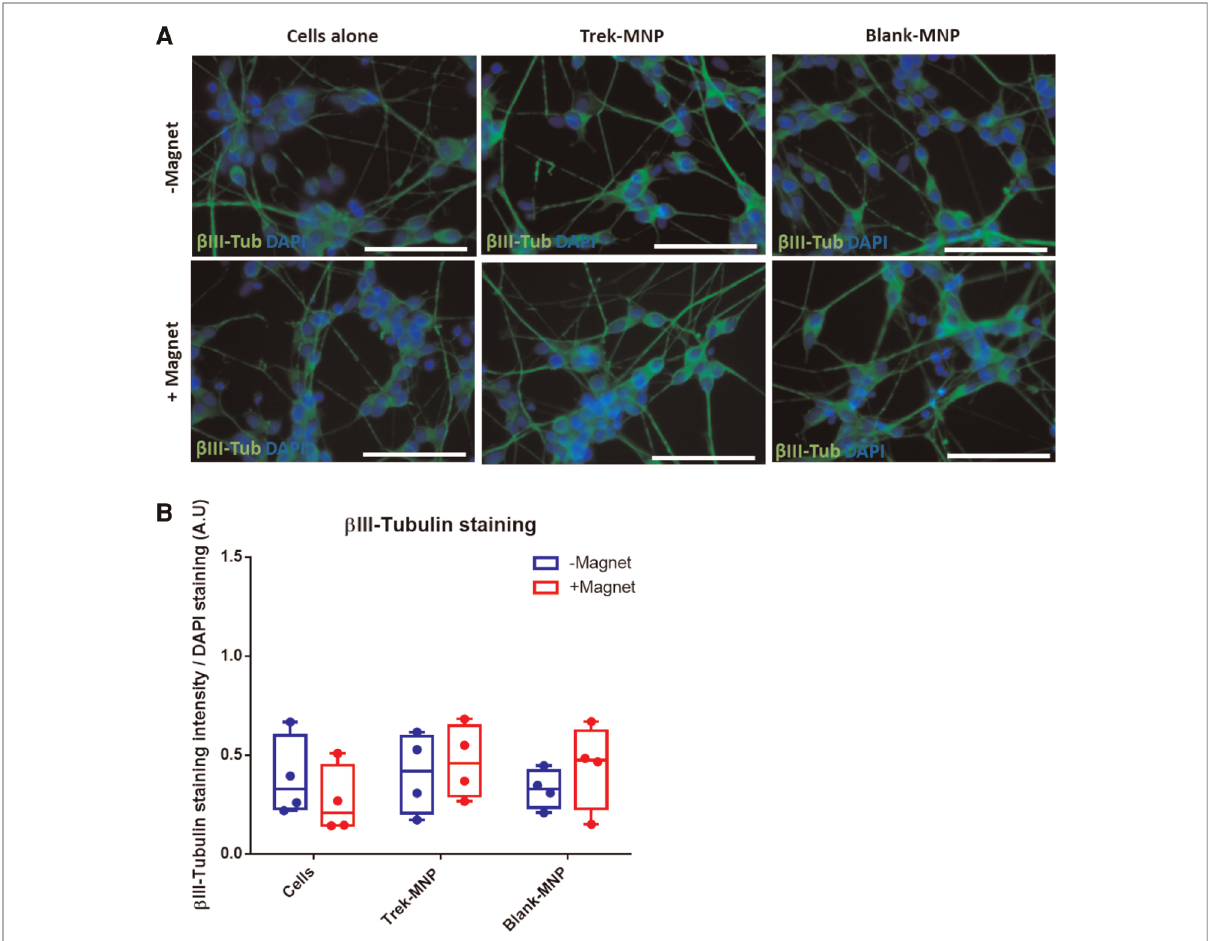
FIGURE 5 TREK-MNP do not regulate SH-SY5Y neuronal differentiation. Immuno fl uorescent microscopy showed that TREK-MNP (alone or with magnetic fi eld stimulation) do not in fl uence neuron morphology or expression of β III-tubulin during RA/BDNF mediated neuronal differentiation ( A ). β III-Tubulin is shown in green, cell nuclei are shown by DAPI staining (Blue), images representative of n =4, bar represents 50 μ m. Pixel intensity analysis of β III- Tubulin staining con fi rmed that neither TREK-MNP nor Blank-MNP had any signi fi cant effect on β III-Tubulin staining intensity ( B ). n =4, plots represent median fold change and